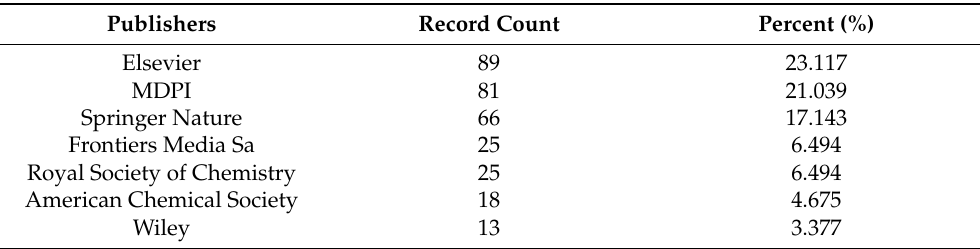
Table 1. The top seven publishers that published papers regarding NPs enhancing abiotic tolerance in plants from 2008 to 2022. Table 2. The top seven periodicals that published papers regarding NPs enhancing abiotic tolerance in plants from 2008 to 2022.